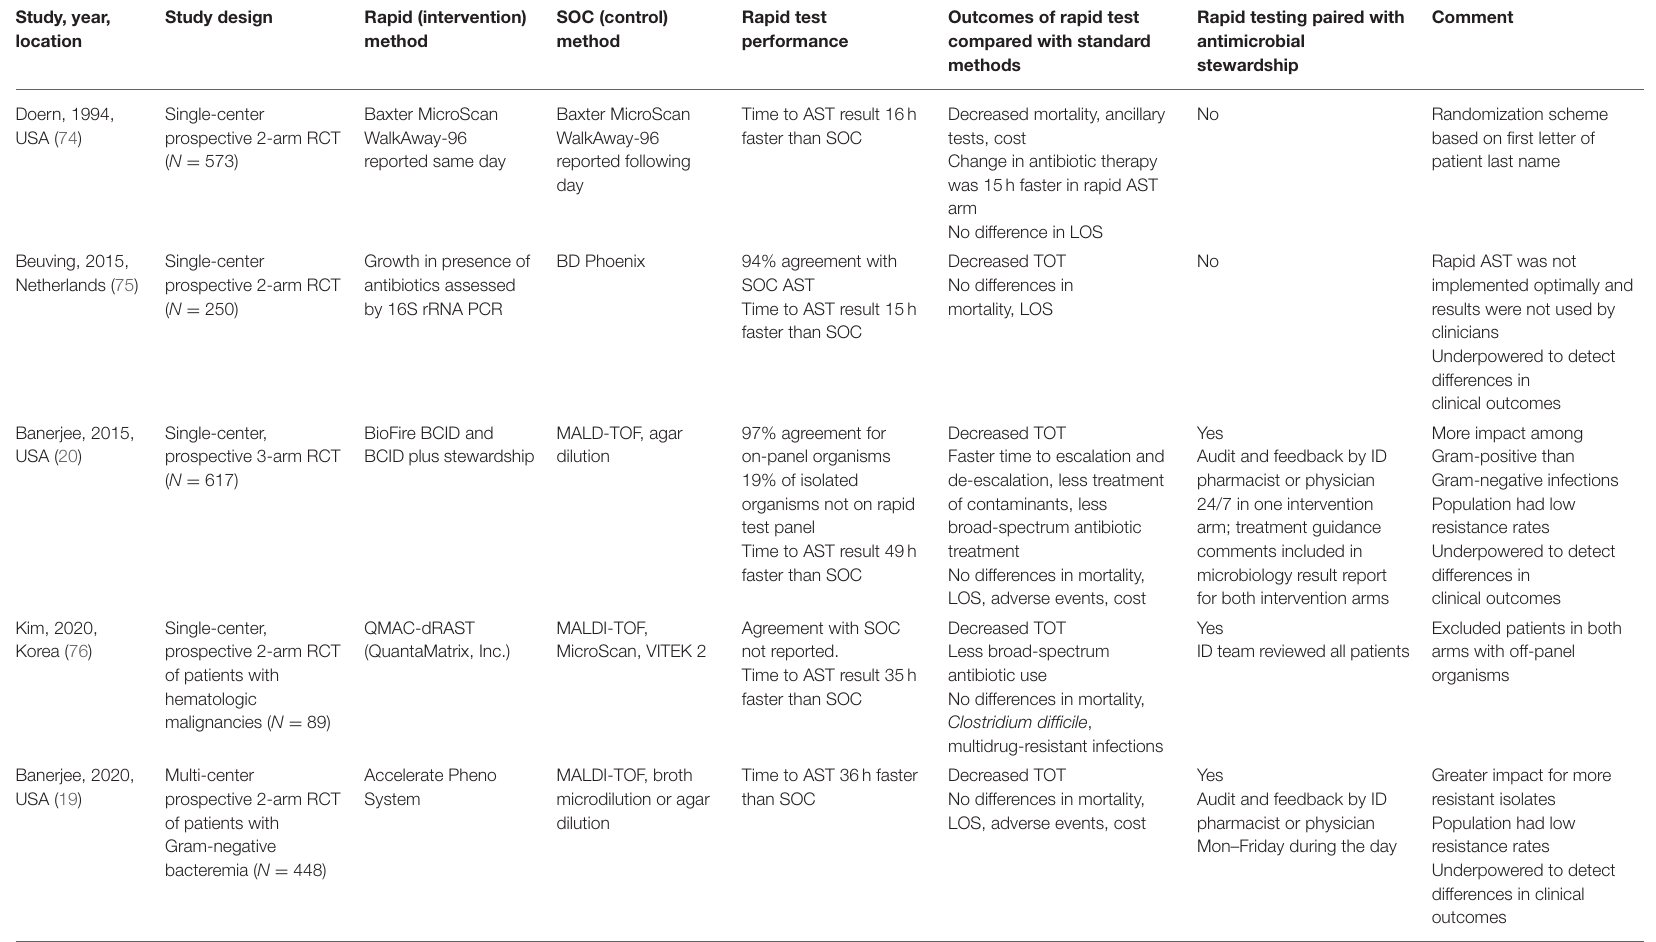
TABLE 3 | Randomized controlled trials evaluating clinical impact of rapid blood culture antimicrobial susceptibility testing